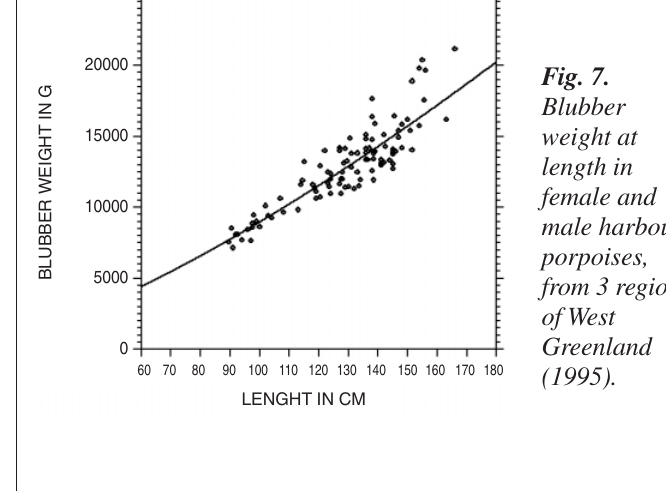
Fig. 8. Muscle weight at length in female and male harbour porpoises, from 3 regions of West Greenland